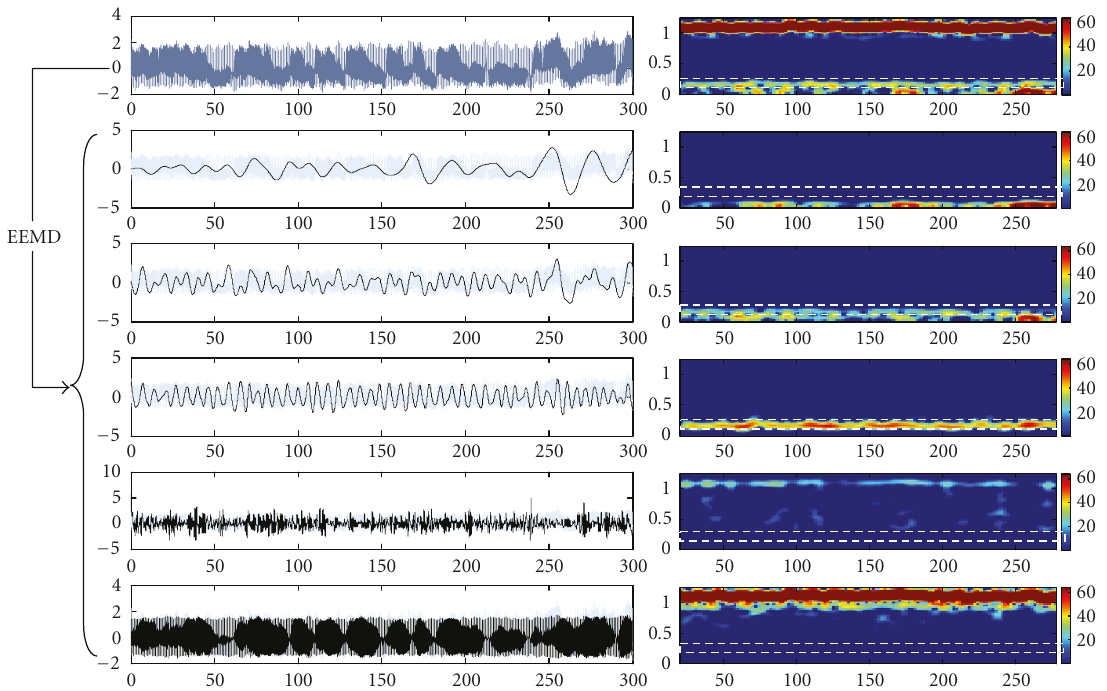
Figure 3: (Left panel) A raw BFV signal and its decomposed empirical modes (i.e., c 5 – c 9 components from bottom to top) obtained by the EEMD method. (Right panel) The corresponding short-time Fourier transform (STFT) spectrograms of the signals in left panel. The spectrograms were calculated and plotted using the same procedure discussed in Figure 1. The noise ratio for EEMD method is